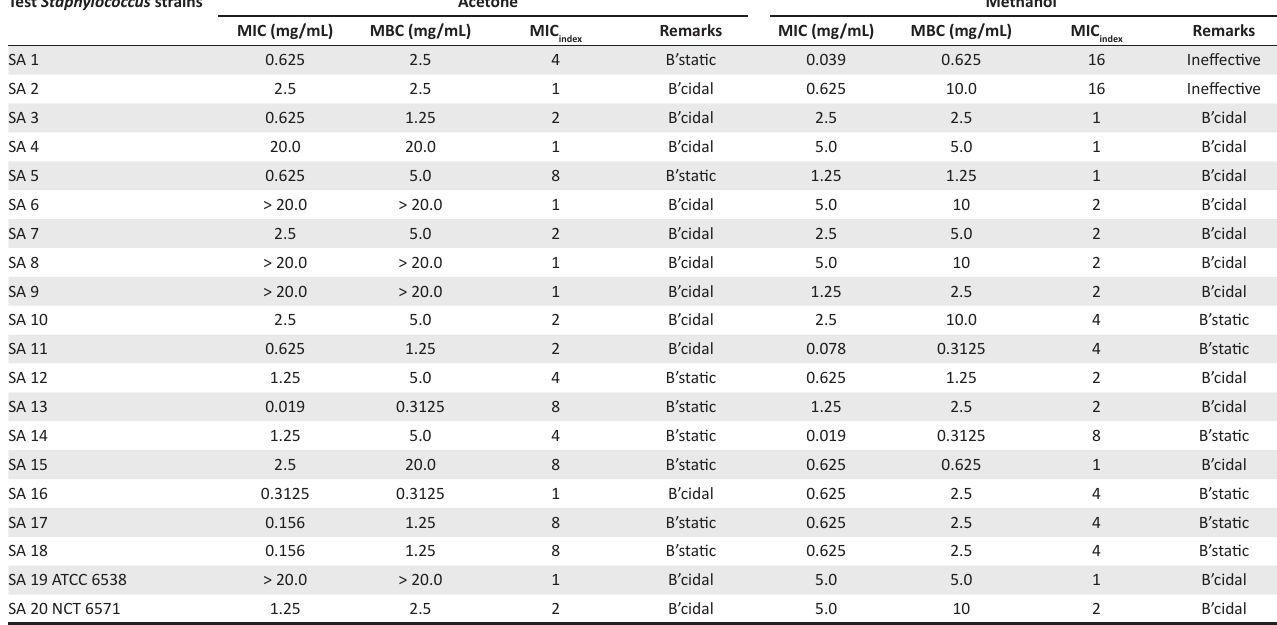
TABLE 3: Antistaphylococcal activities of Tetrapleura tetraptera against Staphylococcus aureus by macrobroth dilution assay. Test Staphylococcus